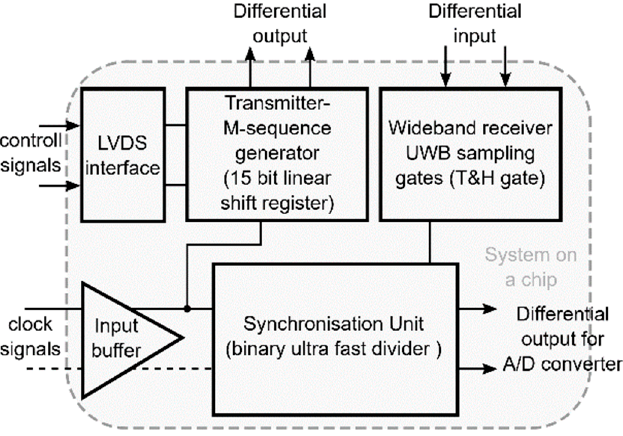
Figure 4. Integrated structure (SoC) diagram of the UWB radar.